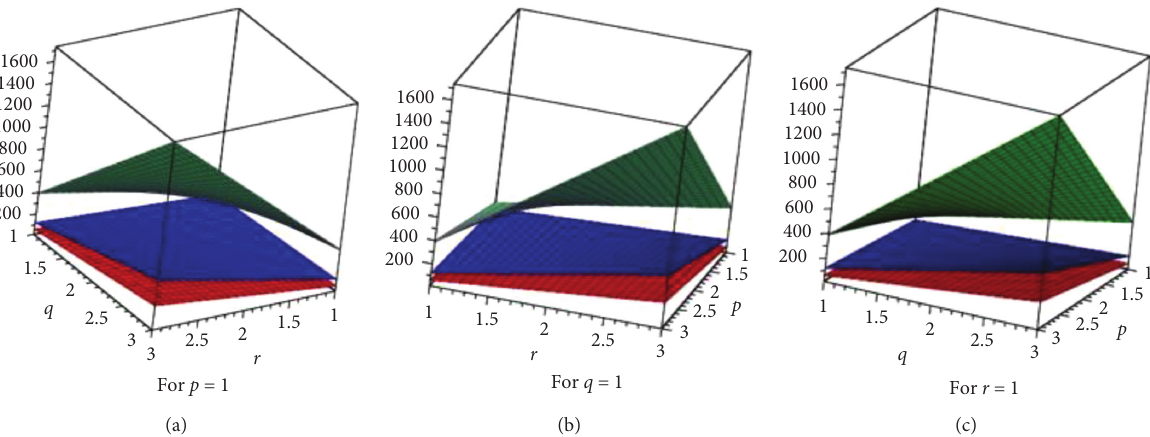
Figure 10: Comparison of IRR , IRR